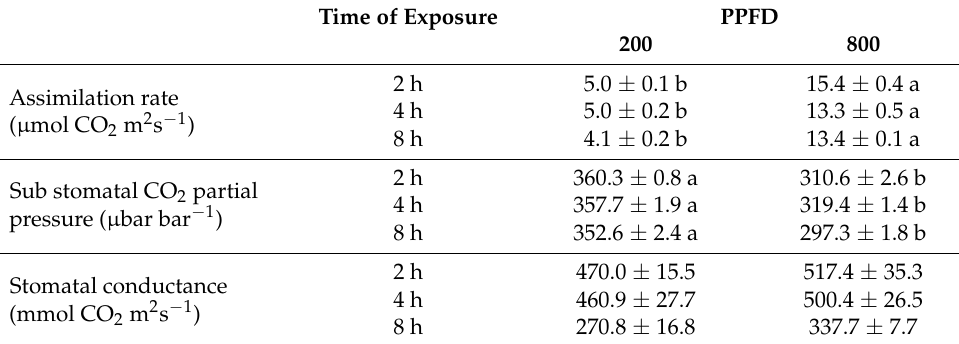
Table 2. Photosynthetic parameters in leaves of spinach plants grown in a growth chamber under